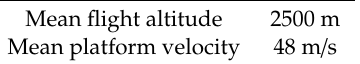
Table 2. Main SAR acquisition